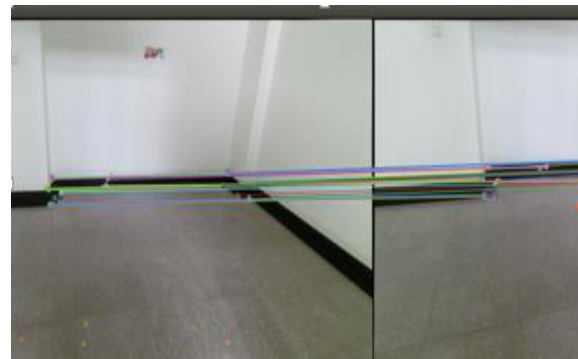
Fig. 3 ORB point feature matching in low-texture scene